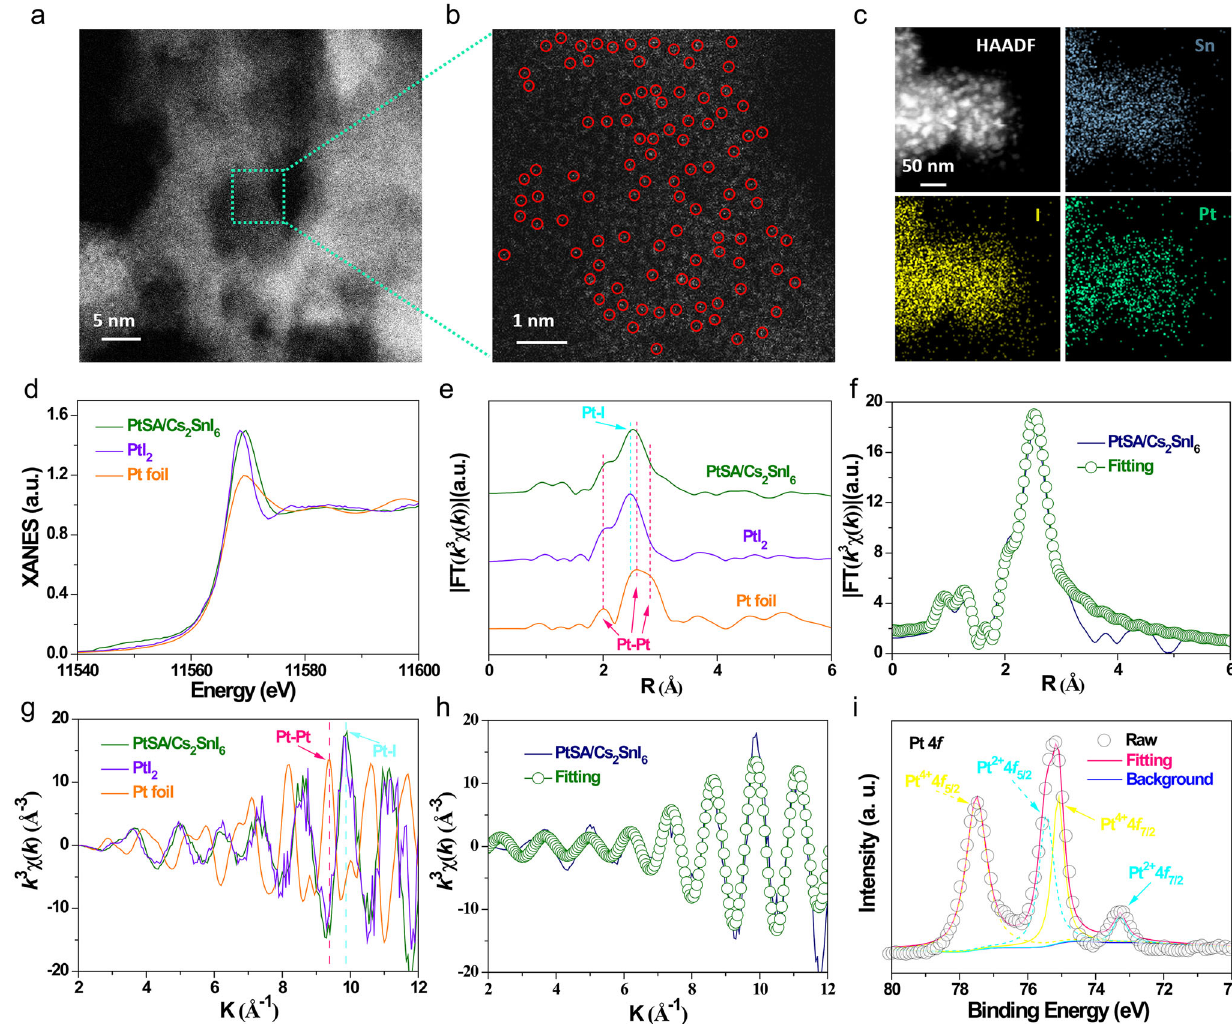
Fig. 2 Structure characterization of PtSA/Cs 2 SnI 6 . a Low-magni fi cation and b high-magni fi cation HAADF-STEM images, and c the corresponding